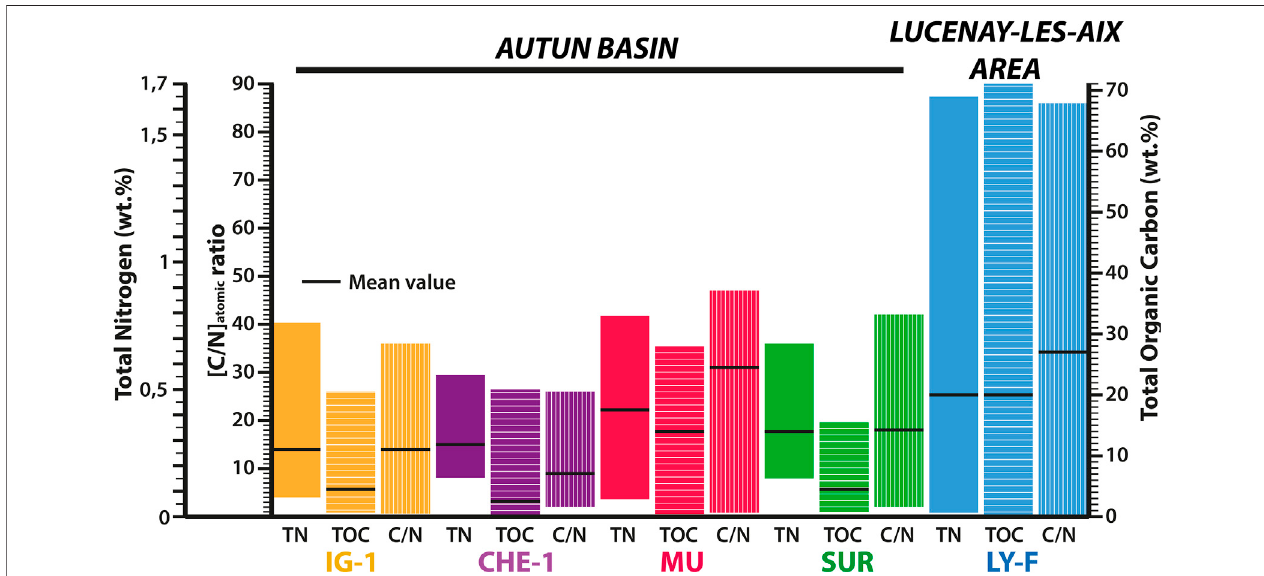
FIGURE10| Histogramsofthedispersionoftotalnitrogen(TN),totalorganiccarbon(TOC)andC/Natomicratiovaluesforallthesectionsstudied;meanvaluesare represented by black horizontal lines; the C and N content is obtained by EA-IRMS. The values display approximatively the same ranges in the Autun Basin, whereas ranges for those of the Lucenay-lès-Aix area are wider.